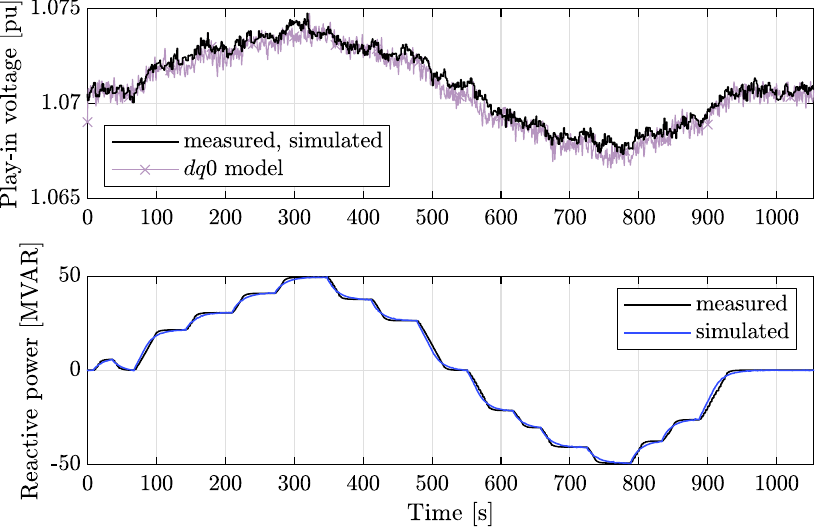
Figure 11. Volt/VAR Control Experiment 3: Reactive power reference step test. Comparison of simulations and experimental results. The reactive power set-point was changed as follows: 0 MVAR → 50 MVAR → − 50 MVAR → 0 MVAR .